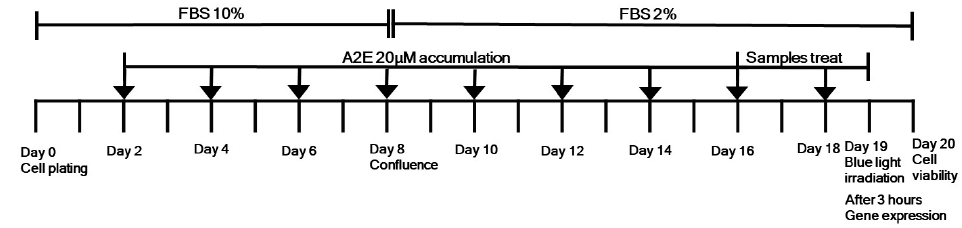
Figure 7. Design of the experiment in the present study.